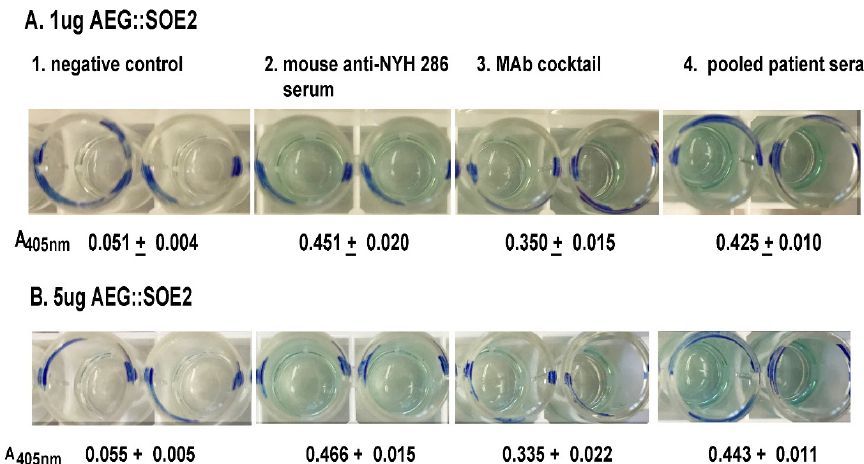
Figure 3. ELISA for detection of AEG::SOE2 at 1 µ g ( A ) and 5 µ g ( B ) AEG::SOE2 immobilized onto individual wells of 96-well microtiter plates. The negative controls were wells incubated with five di ff erent pooled negative sera each from women and men. This sera were shown previously to have no reactivity with any T. vaginalis proteins by immunoblot [24] (wells numbered 1). Wells with the di ff erent concentrations of AEG::SOE2 protein were incubated with mouse anti- T. vaginalis serum [31] (wells numbered 2), a cocktail of MAbs reactive with AEG::SOE2 epitopes as shown in Figure 1 (wells numbered 3), and with five di ff erent pooled positive women and men sera (wells numbered 4). The negative and positive pooled women and men sera have been previously reported [26]. Values were obtained by absorbance at 405 nm. As expected, a negative control irrelevant MAb to α -actinin called HA423 [24] was unreactive to AEG::SOE2 by ELISA, as shown in Figure 4. The ELISA was repeated on four different times with similar results.